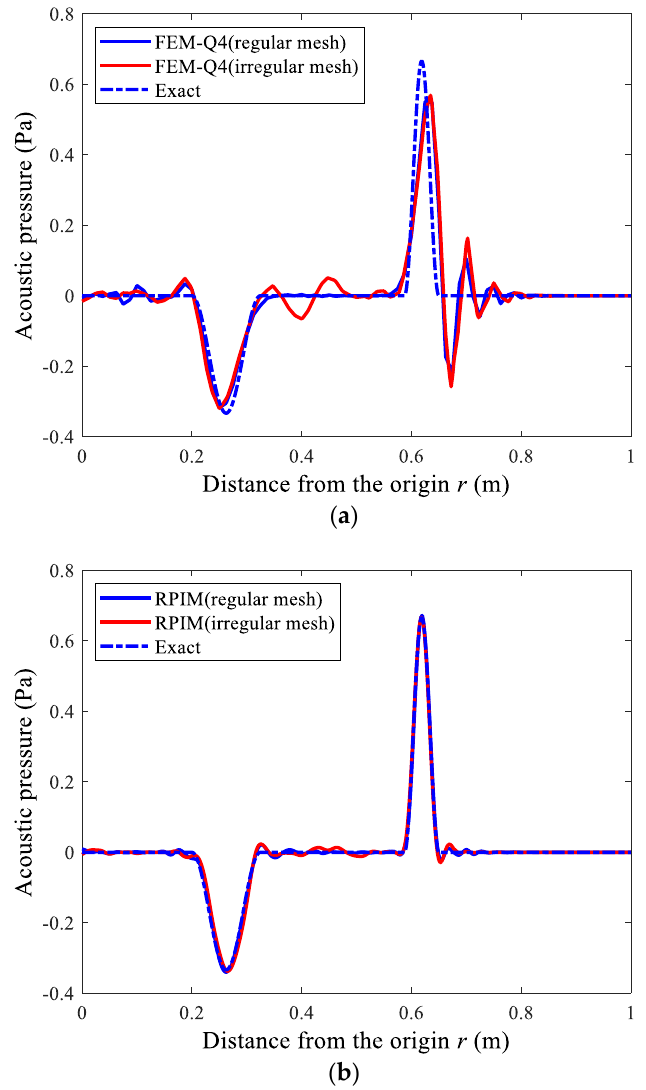
Figure 12. Comparisons of the acoustic pressure distribution results for different meshes and differ- ent numerical approaches when the time point t = 0.8 s: ( a ) FEM-Q4; ( b ) RPIM.